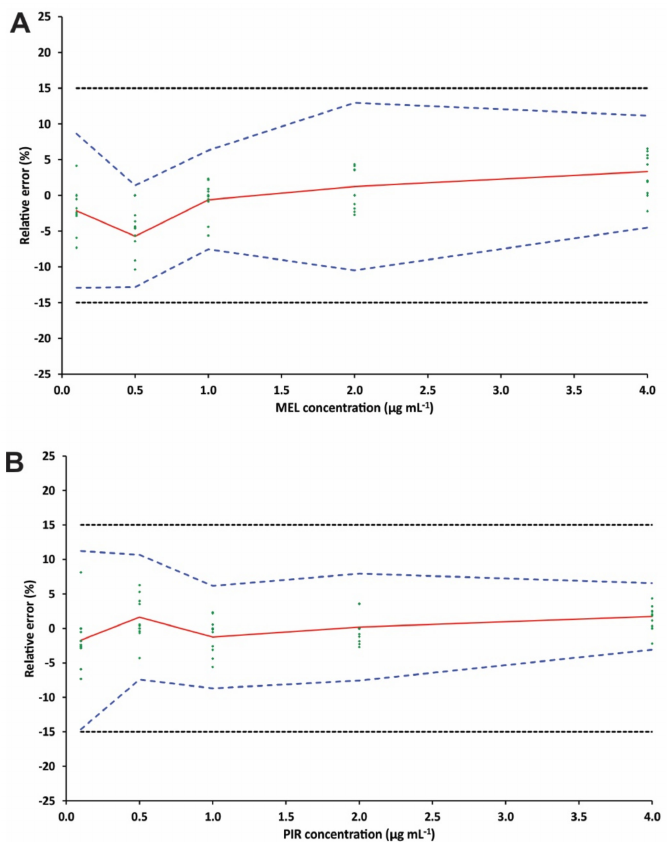
Figure 5. Accuracy profiles for the determination of ( A ) MEL and ( B ) PIR in human urine samples using unweighted linear regression models. The relative error (%) is represented by the red plain lines, the accuracy profiles are represented by the blue dashed lines and the acceptance limits λ ( ± 15%) are represented by the blank dotted lines.